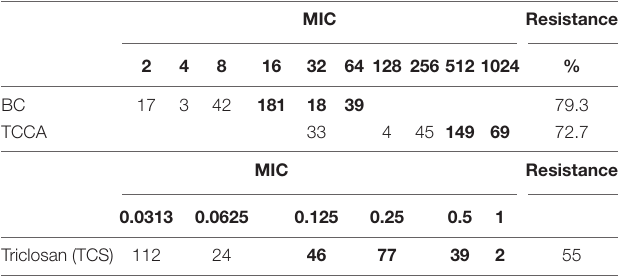
TABLE 4 | Incidence of disinfectants among 300 Salmonella Typhimurium strains isolated from pig meat, pig manure, poultry manure, chicken meat, and human stool samples.